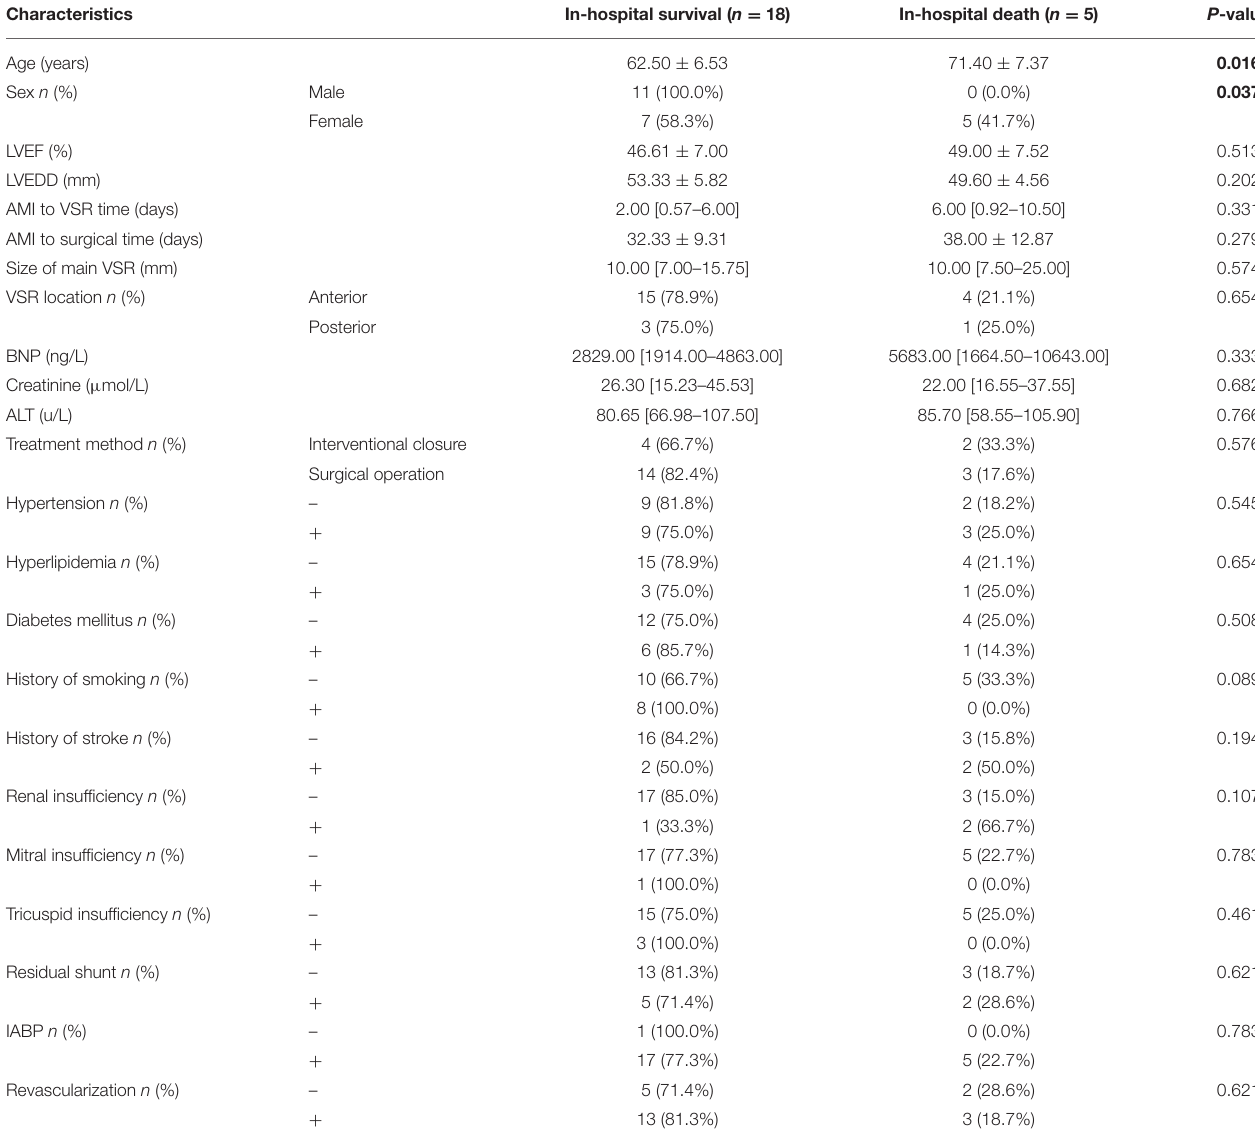
TABLE 2 | Baseline characteristics of hospitalized